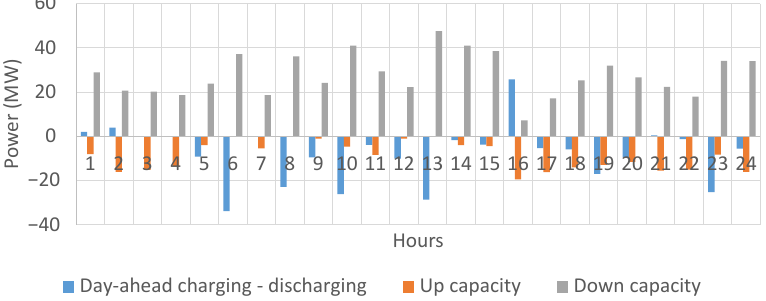
− q dis ) and up/down cleared reserve capacity q dis t t